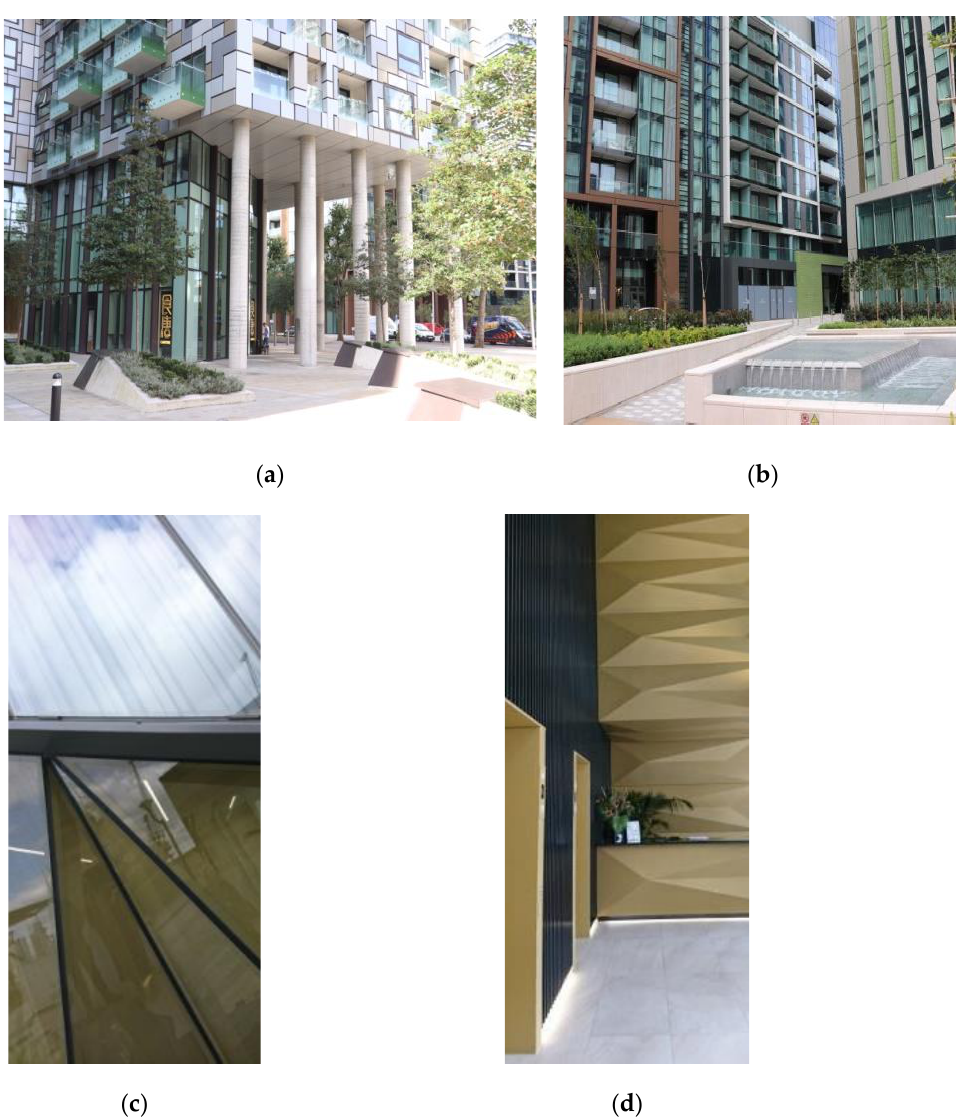
Drive with horizontal hierarchy of textures.